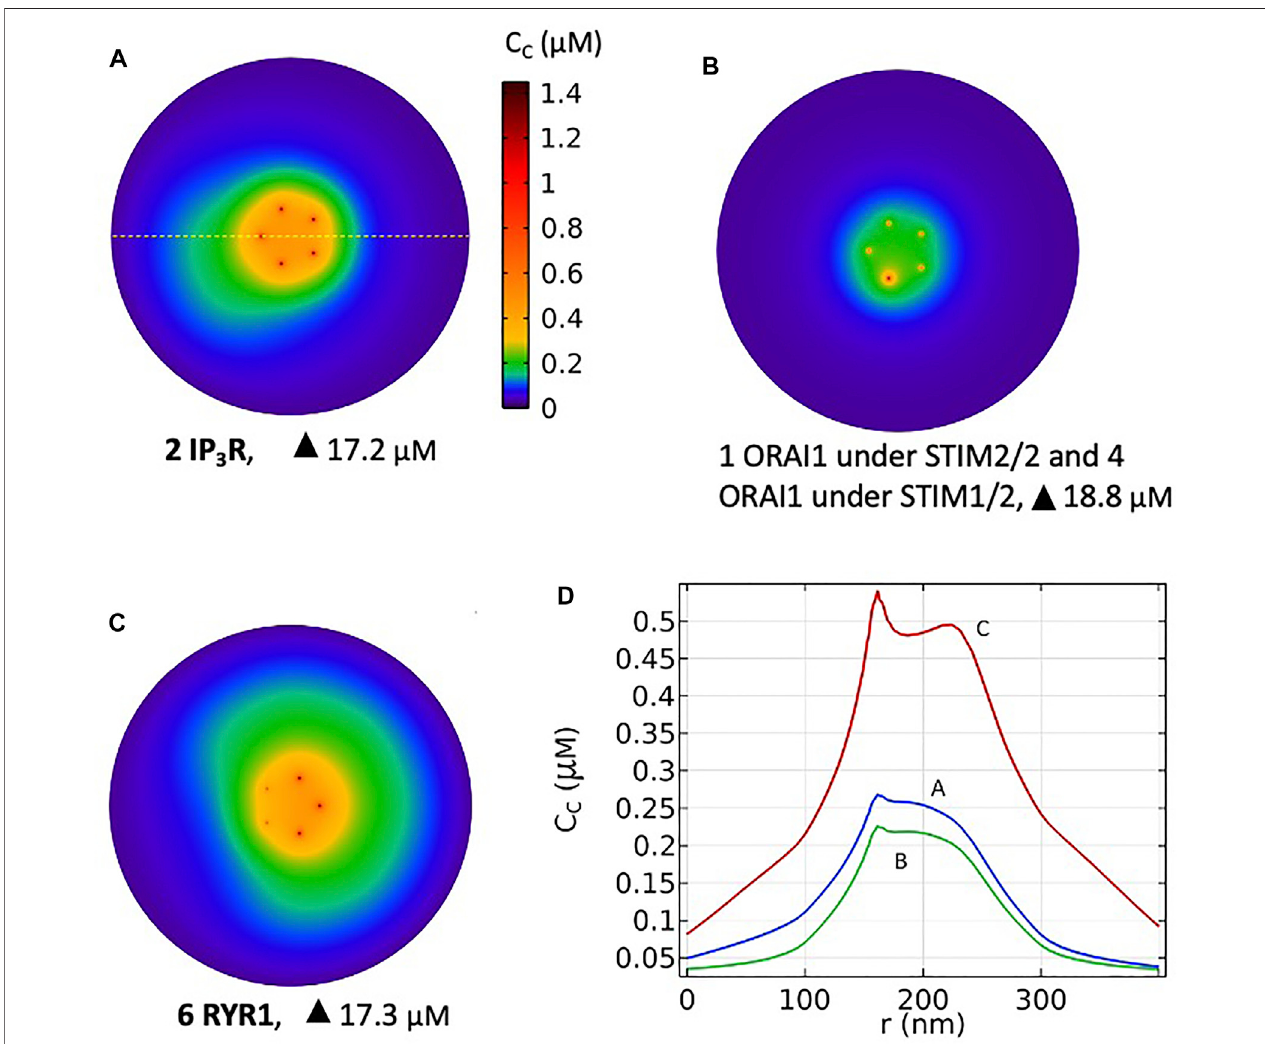
FIGURE 10 | Simulated most probable Ca 2+ microdomains resulting from a T cell transition between quiescent to early activation. (A) Non TCR/CD3-dependent Ca 2+ microdomains formed by the opening of two IP 3 Rs adjacent to the junction and further opening of ORAI1 channels bound to STIM2/2 (B) Basal opening of fi ve ORAI1 channels, one inherently co-localized with STIM2/2 and four inherently co-localized with STIM1/2 leading to small microdomains arising from nano-scale [Ca 2+ ] fl uctuationsinthesub-PM ER.Arti fi cialconstruction (C) TCR/CD3-dependent Ca 2+ microdomainsformed bytheopening ofsixRYR1 adjacent tothejunctionand furtheropening ofORAI1 channelsbound toSTIM1/2.See Anim. S5a,b,c inthe SupplementaryInformation . (D) Ca 2+ pro fi les alongthe yellow dotted lineshown inA that traverses the middle of the junction at a 7.5 nm distance from the PM, corresponding to panels A, B and C.